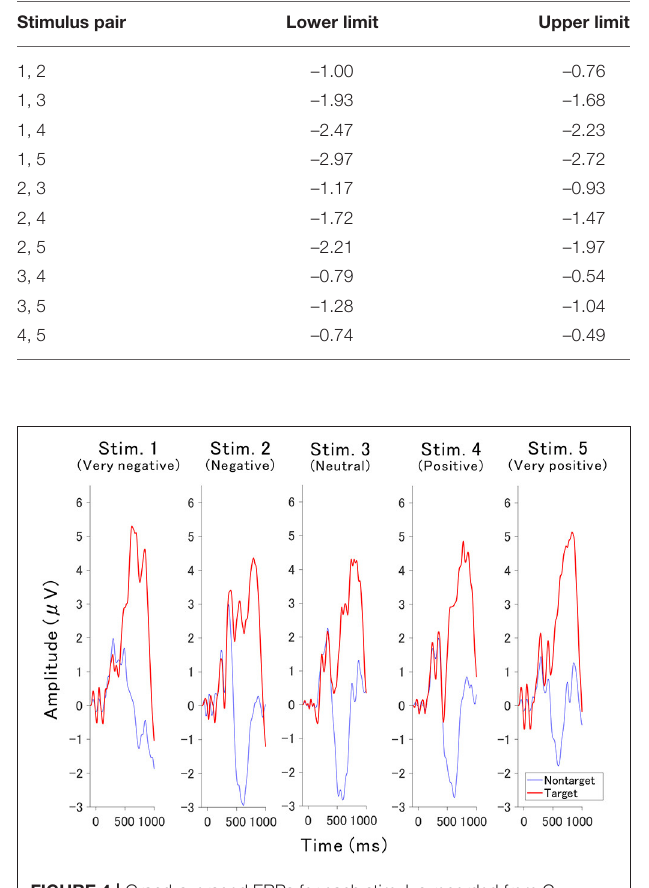
FIGURE 4 | Grand-averaged ERPs for each stimulus recorded from Cz.